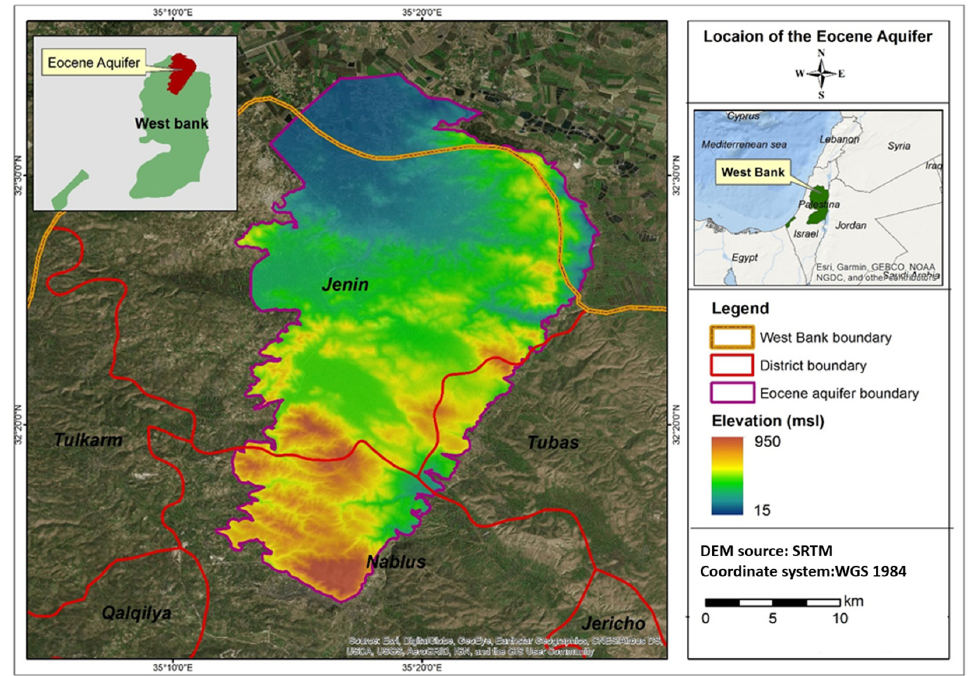
Figure 2. Location of the Eocene aquifer and its elevation.